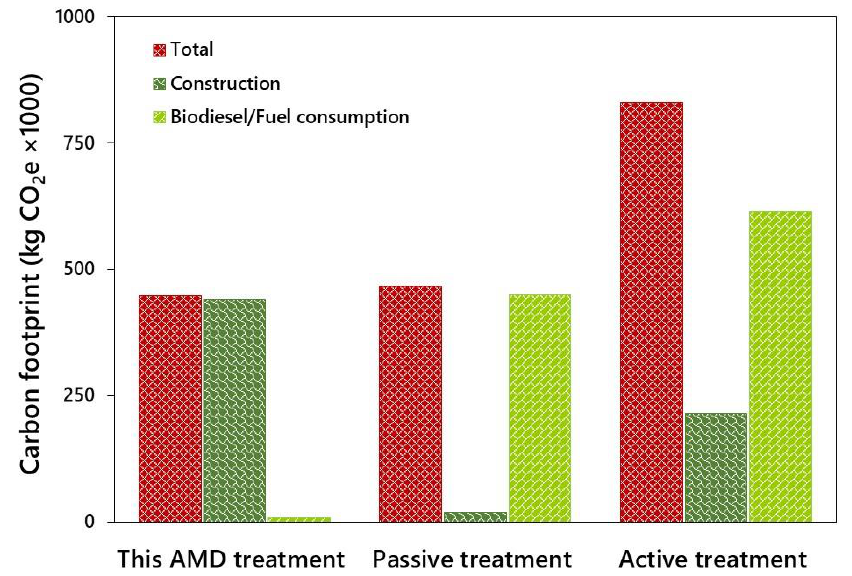
Figure 2. A comparison of carbon footprint - this AMD treatment (immobilized microalgal system), passive treatment [27], and active treatment [27] of AMD. Table 3. Direct and indirect greenhouse gas emissions based on Australia’s National Greenhouse Energy Reporting (NGER).